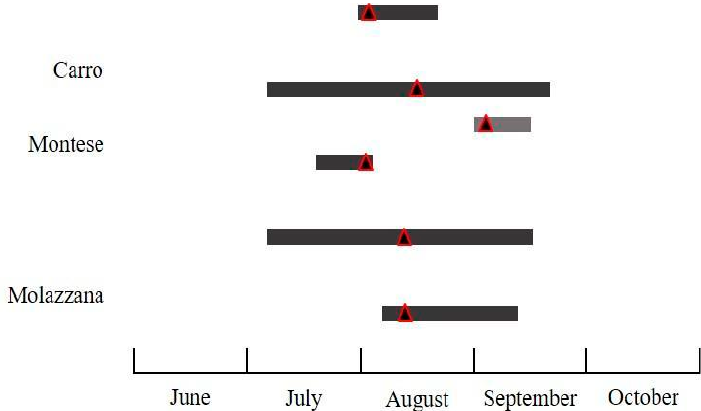
Figure 5. Seasonal flight activity of Cydia fagiglandana (Zeller) recorded in the surveyed sites using the experimental pheromone (grey bars refer to 2018, black bars to 2019. For each bar, the triangle corresponds to the population